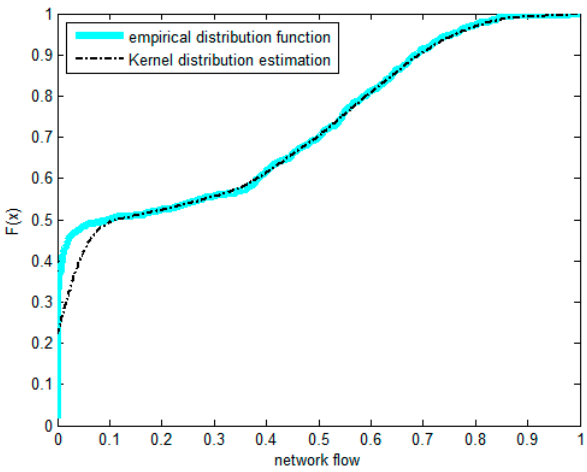
Figure 7. Density function of flow.